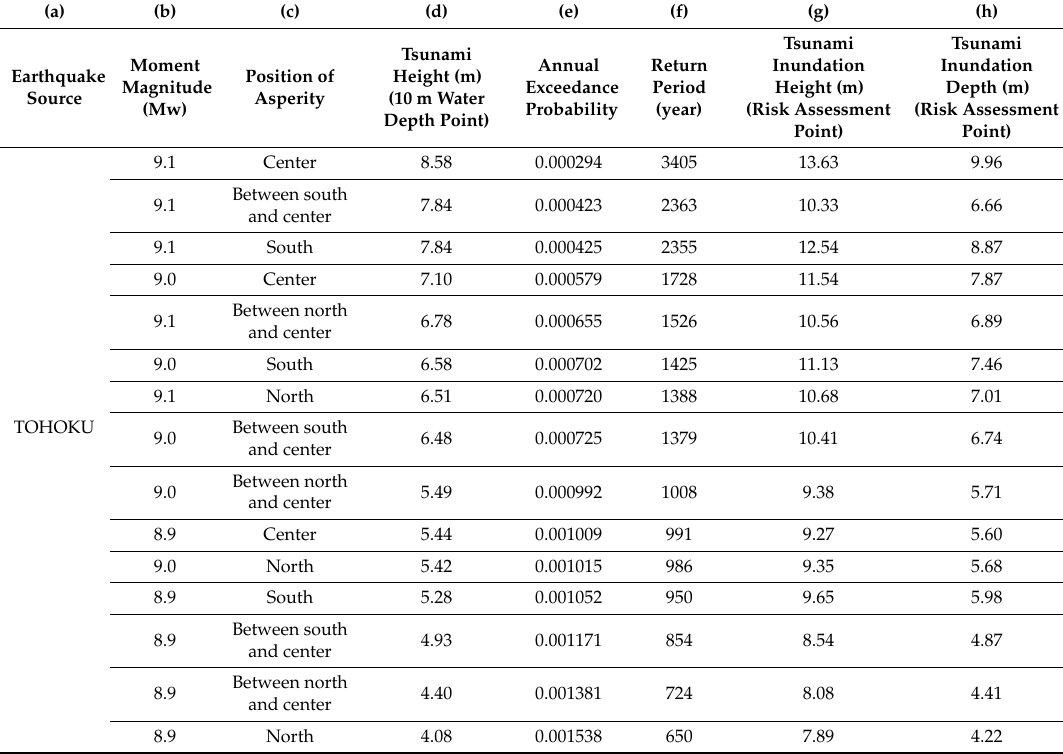
Table 6. Calculation results for Soma. (a) Earthquake source name; (b) moment magnitude of the earthquake; (c) position of the asperity; (d) tsunami wave height at a water depth of 10 m; (e) annual exceedance probability estimated using the tsunami hazard curve; (f) return period calculated from the annual exceedance probability; (g) tsunami inundation height at the risk assessment point simulated using a nonlinear longwave equation with the fault